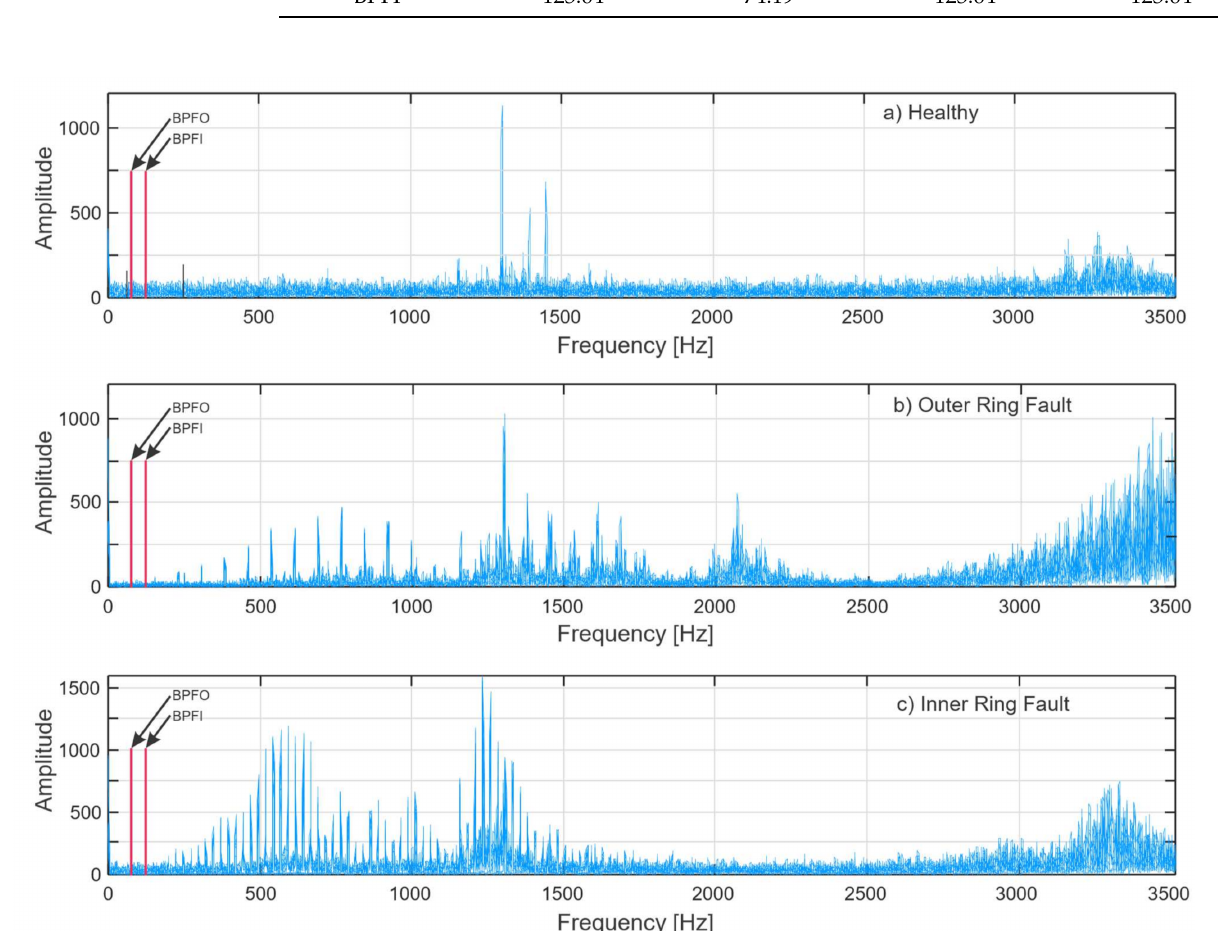
Figure 7. Raw vibration signal spectra of: ( a ) Healthy bearing; ( b ) Bearing with inner ring fault; ( c ) Bearing with outer ring